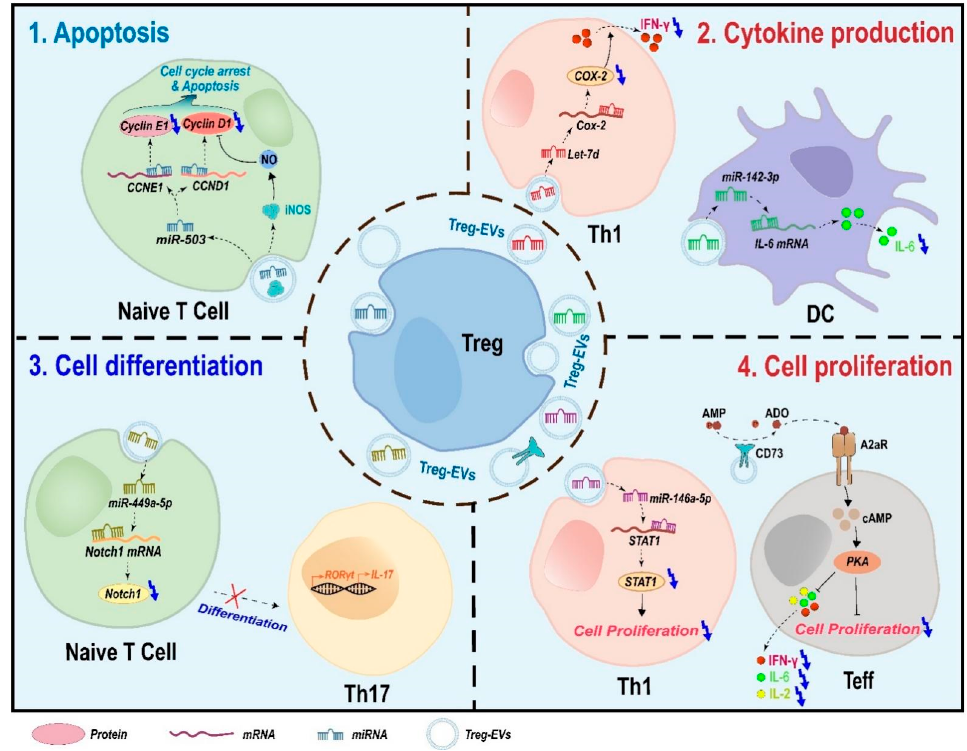
Figure 2. Schematic model for the suppressive mechanisms of Treg-EVs. Treg-EVs affect a variety of physiological processes including cell proliferation, apoptosis, cytokine production, and cell dif- ferentiation.